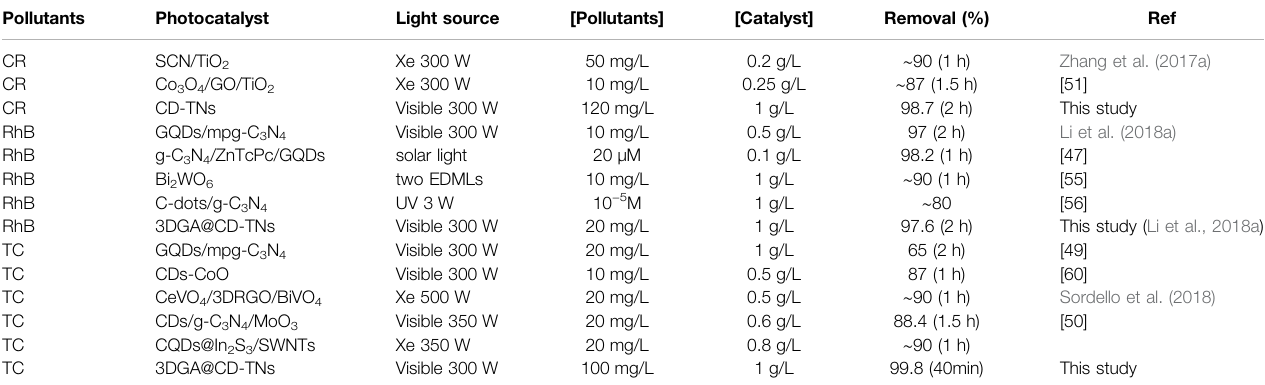
TABLE 3 | Comparison of CR, RhB, and TC degradation over different